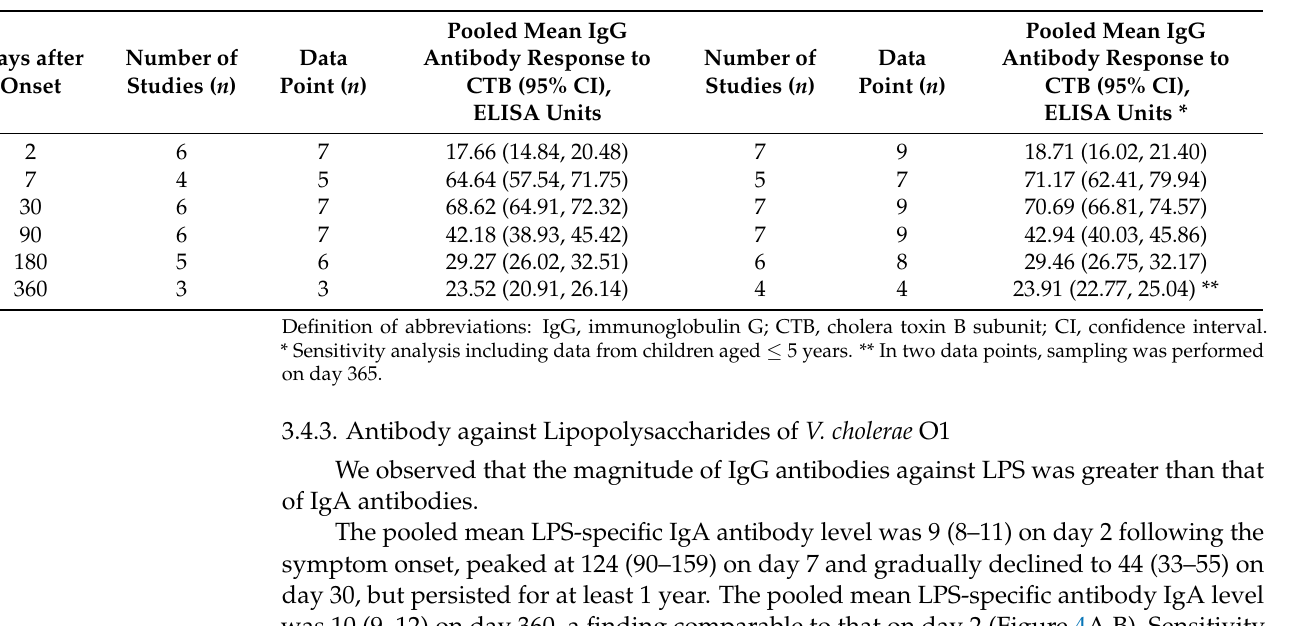
Table 3. Kinetics of anti-cholera toxin B subunit IgG following cholera.